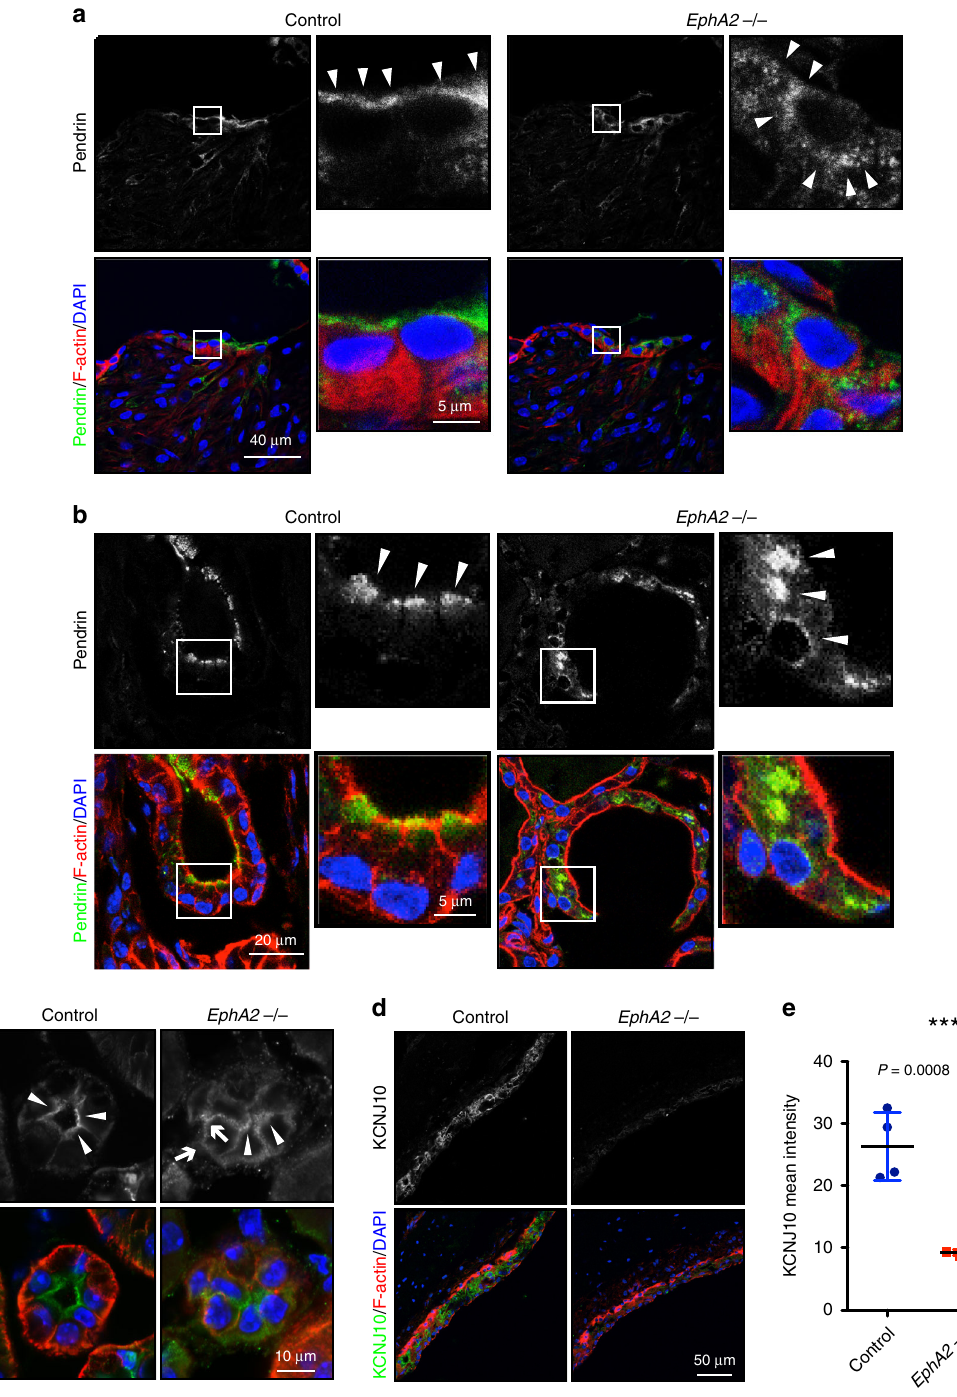
Fig. 3 Compromised localization of pendrin in EphA2 KO mice. a Immunostaining of pendrin in the inner ear of control and EphA2 KO mice. Green, pendrin; red, actin; blue, DAPI. Arrowheads indicate the immunoreactive signal corresponding to pendrin. b Immunostaining of pendrin in the thyroid of control and EphA2 KO mice. Green, pendrin; red, actin; blue, DAPI. Arrowheads indicate the immunoreactive signal corresponding to pendrin. c Immunostaining of pendrin in the kidney of control and EphA2 KO mice. Green, pendrin; red, actin; blue, DAPI. Arrows and arrowheads indicate the immunoreactive signal corresponding to pendrin. d Immunostaining of KCNJ10 in the inner ear of control and EphA2 KO mice. KCNJ10 expression in stria vascularis shown in green was reduced in EphA2 KO mice. e Average data from four animals are presented. Lines indicate mean value from 4 animals with SD. *** p < 0.001 by Student ʼ s t -test. Source data are provided as a Source Data fi